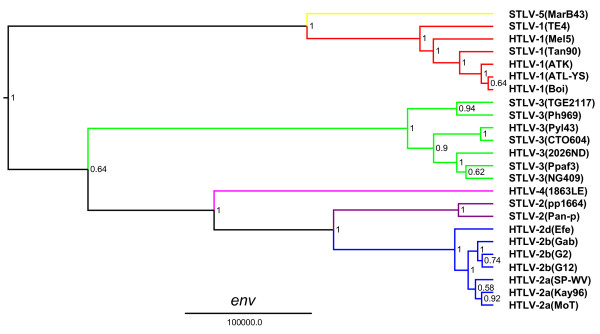
Phylogenetic relationship of HTLV-4(1863LE) to other PTLVs in env using Bayesian inference. First and second codon positions of env sequences were used to generate PTLV phylogenies by sampling 10,000 trees with a Markov Chain Monte Carlo method under a relaxed clock model, and the maximum clade credibility tree, i.e. the tree with the maximum product of the posterior clade probabilities, was chosen. Branch lengths are proportional to median divergence times in years estimated from the post-burn in trees with the scale at the bottom indicating 100,000 years. Posterior probabilities for each node are indicated. Branches leading to PTLV-1, HTLV-2 and PTLV-3 sequences are drawn in red, blue and green respectively. The branch leading to HTLV-4(1863LE), STLV-2, and to the divergent MarB43 strain are drawn in magenta, purple, and yellow respectively.